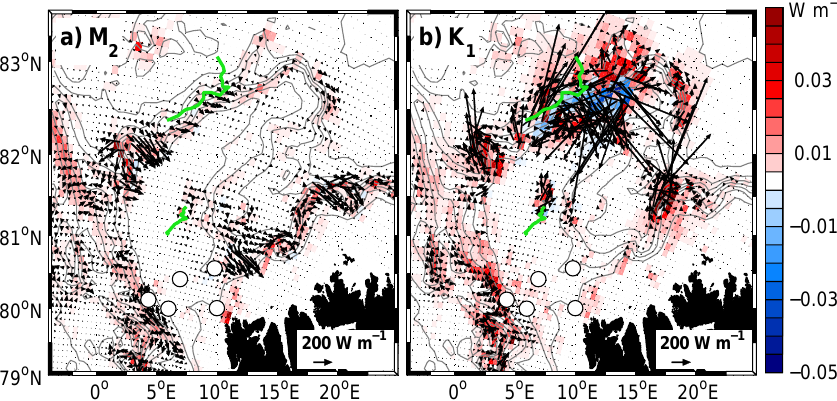
Figure 6. Barotropic-to-baroclinic conversion rate (colour) and the depth-integrated baroclinic energy fluxes (arrows) obtained from STORMTIDE for the (a) M 2 and (b) K 1 constituents. Isobaths (grey) are drawn at 500m intervals from the model topography. Station posi- tions (open circles) and the drift of CEAREX-O (Padman and Dillon, 1991) and MIZEX83 (D’Asaro and Morison, 1992) (green) are shown for